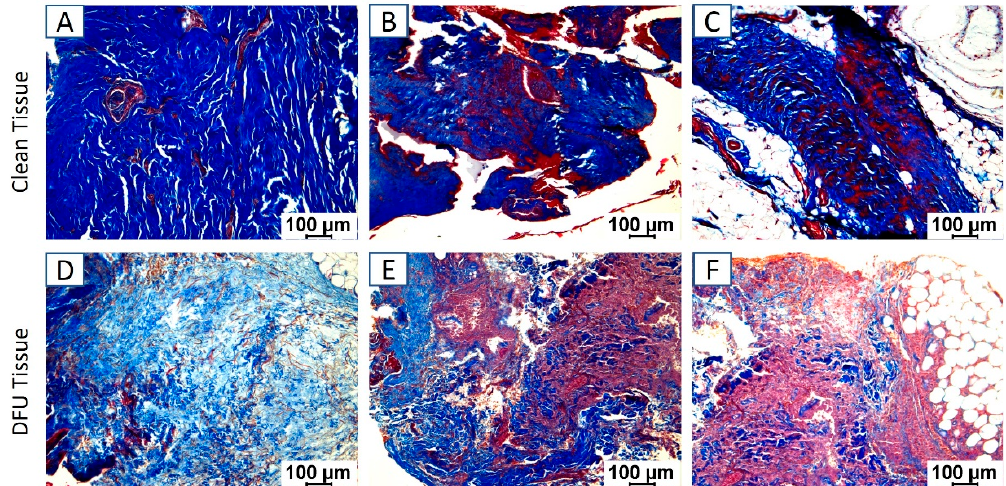
Figure 3. Masson’s trichrome staining in clean and diabetic foot ulcer (DFU) tissues. Clean tissues ( A – C ) and DFU tissues ( D – F ). The images are representative images for both clean and DFU sam-